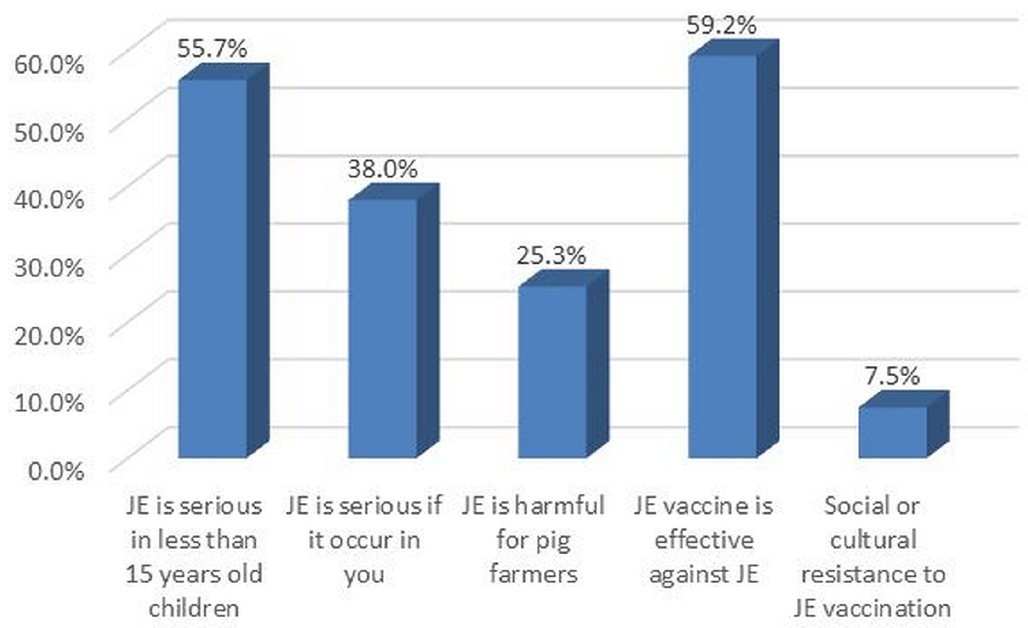
Figure 3. Perception of participants* in the Japanese encephalitis survey, Yangon region, Myanmar (2019) **. The variable “JE is serious if it occur in you” was included because sometimes adults think that some kinds of mosquito borne diseases such as Japanese encephalitis and Dengue are more serious in children and not serious when those diseases occur in them. Researchers in this study wanted to know whether participants had these perceptions. JE, Japanese encephalitis. Y axis as percentage (responded ‘yes’). *Parent or guardian of the 1–15 year-old children available at time of survey, preferably mother. **Weighted estimates given taking into account the sampling